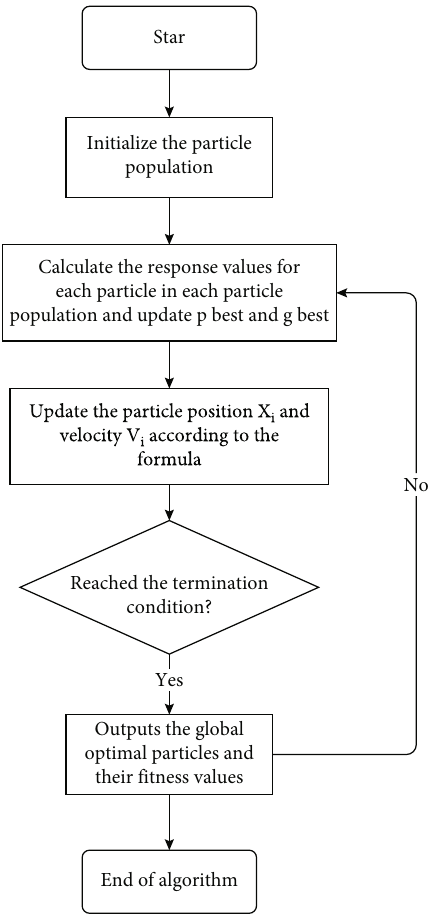
Figure 2: Flowchart of particle swarm